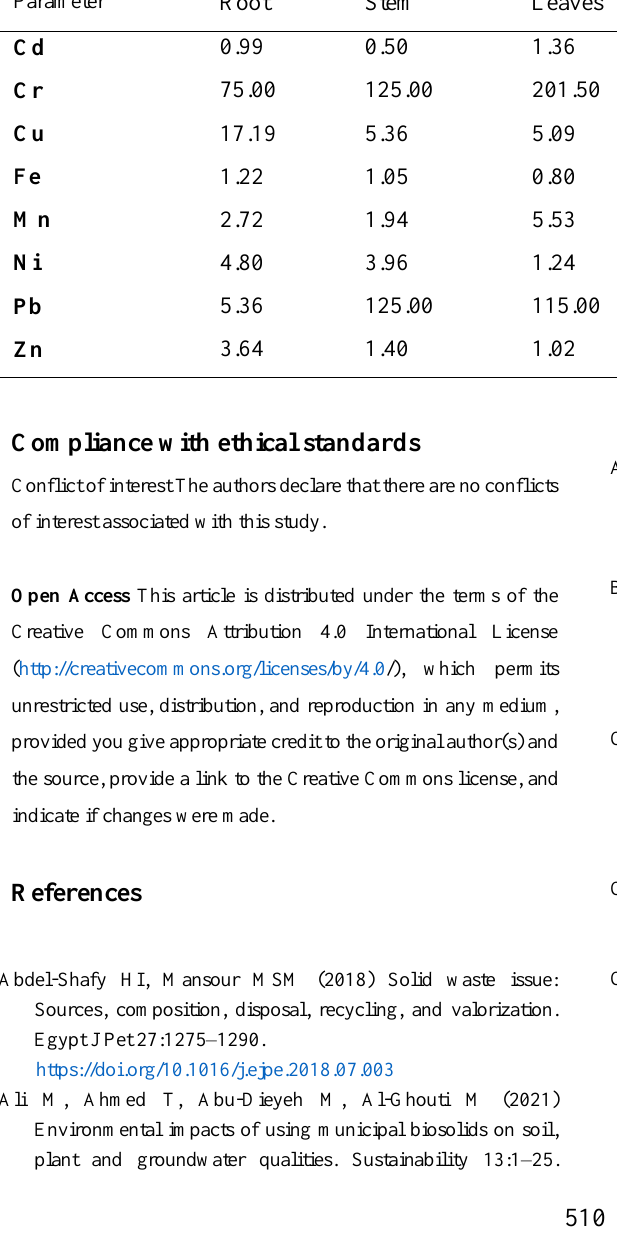
Table 6 The enrichment factor of metals in plants parts and soil